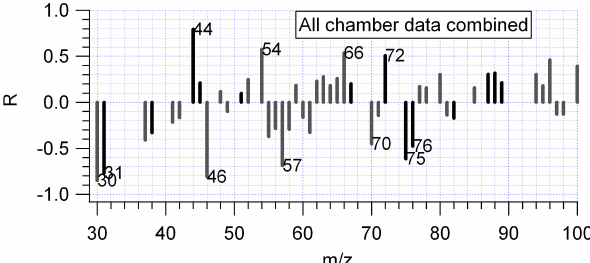
Fig. 5. Correlation coefficient between κ org and each f x for the complete smog chamber data set. Black bars indicate that the m/z had a similar sign for R for all precursors studied here. In contrast grey bars indicate that for one precursor R has a different sign com- pared to the other precursor for the same fragment. Data with a significance α > 0 . 05 are not